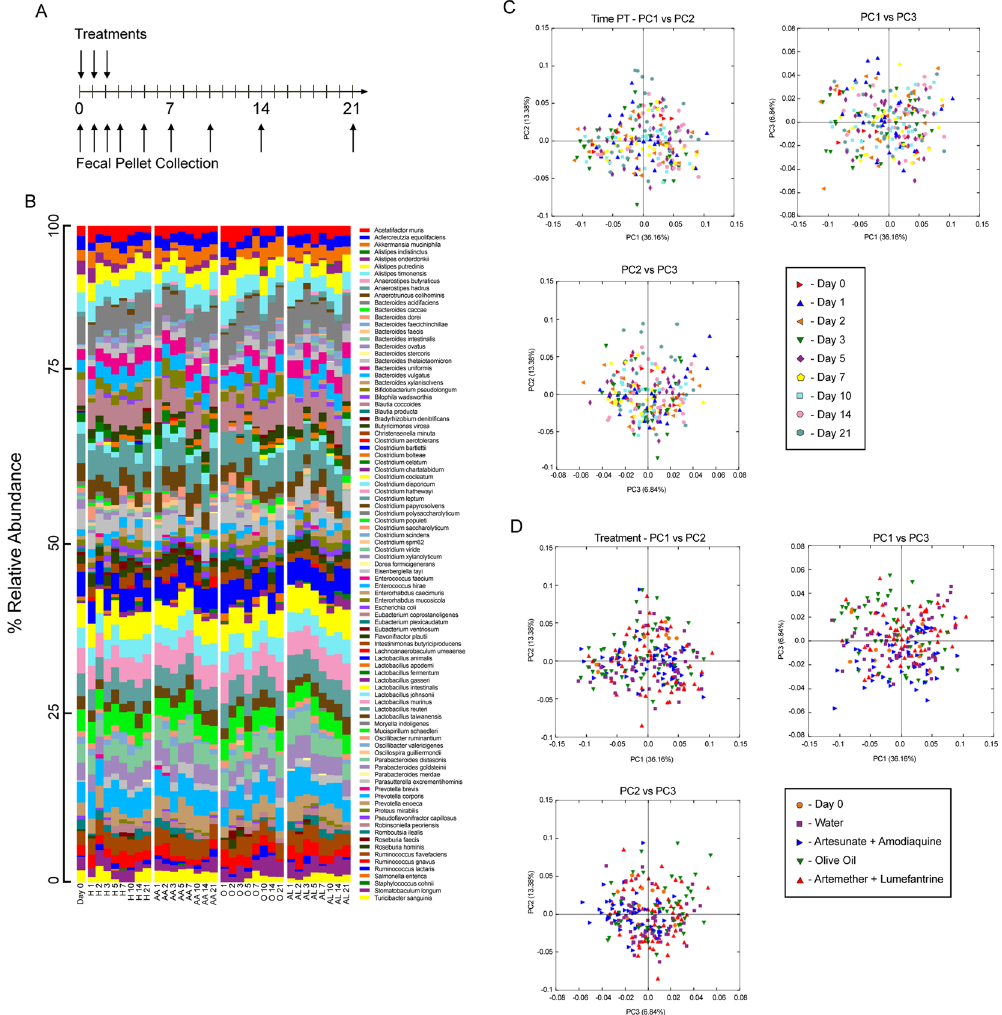
Figure 1. Relative bacterial abundances remain stable despite antimalarial treatments. ( A) Experimental design for antimalarial treatments and fecal pellet collections. ( B) Relative taxonomic abundances of bacterial species among different treatment groups. Time points are collapsed by average abundance and scaled to sum to 1. PCoA plots of weighted UniFrac distances between samples, with either ( C) time p.t. or ( D) treatment metadata distinguishing samples; this data is further analyzed in Figs 2 and 3. Data are the cumulative results of 2 experiments (4 mice/group/experiment); untreated (day 0) data for each group is